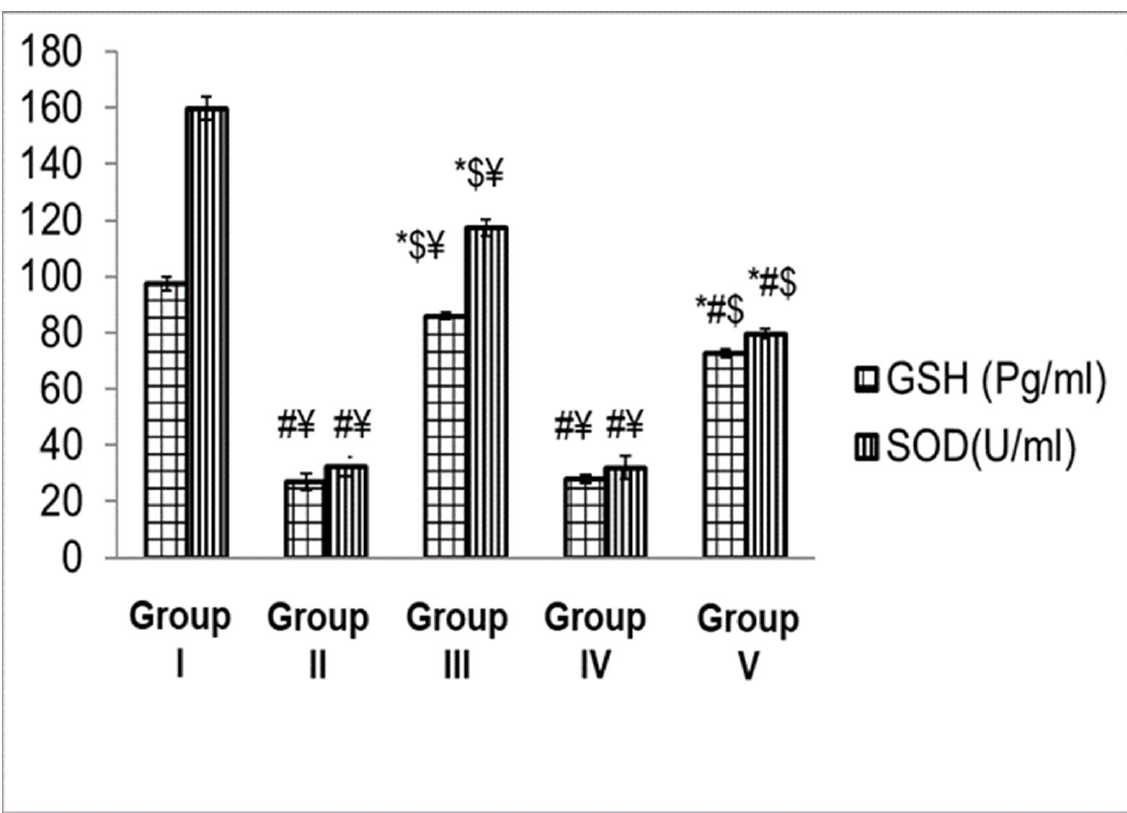
Figure 11. Levels of oxidative stress markers (GSH and SOD) determined for Group I (negative control, shaved animal skin was not swapped with S. aureus, and no samples were swapped after- wards), Group II (positive control, animal skin was swapped only with S. aureus, and remained untreated), Group III (shaved animal skin was swapped with S. aureus followed by swapping with ZnO-NPs group), Group IV (shaved skin was swapped with S. aureus and then swapped with 3% PVP), and Group V, (shaved animal skin was swapped with bacteria and then after swapped with Sterillium). Data are expressed as average of results, which are the average of five independent readings. Error bars represent standard error. Data were analyzed by one-way ANOVA. *, #, $, and ¥ represent significant differences at p < 0.05, where * represents significant differences when compared to positive control group, # represents significant differences when compared to ZnO-NPs group, $ represents significant differences when compared to 3% PVP group, ¥ represents significant differences when compared to